Question: Sum up the contents of this chart in one sentence.
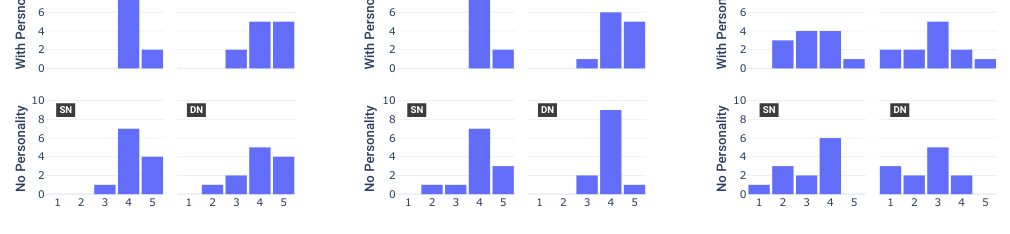
Answer: Distributions of the subjective ratings from three scale questions in the exit survey, with breakdowns by the information format and the personality modifier.